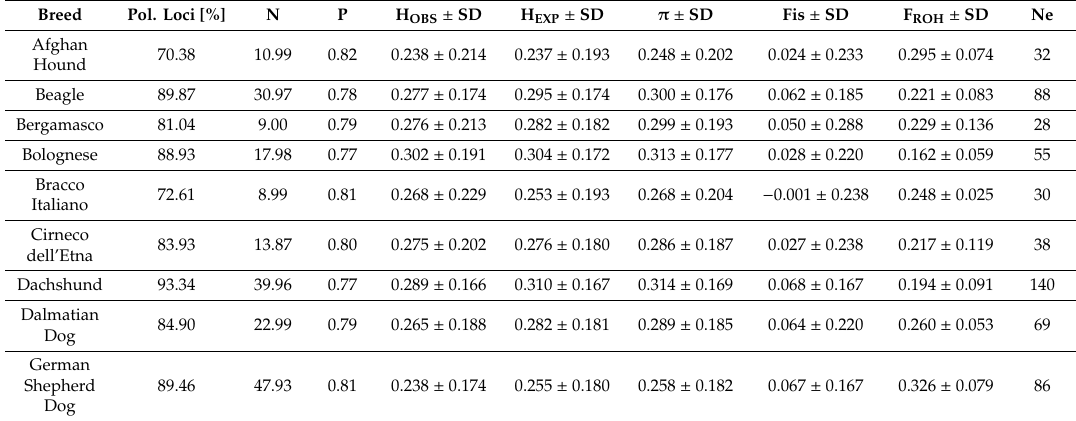
Table 3. Summary population genetics statistics for 32 investigated dog breeds and Grey